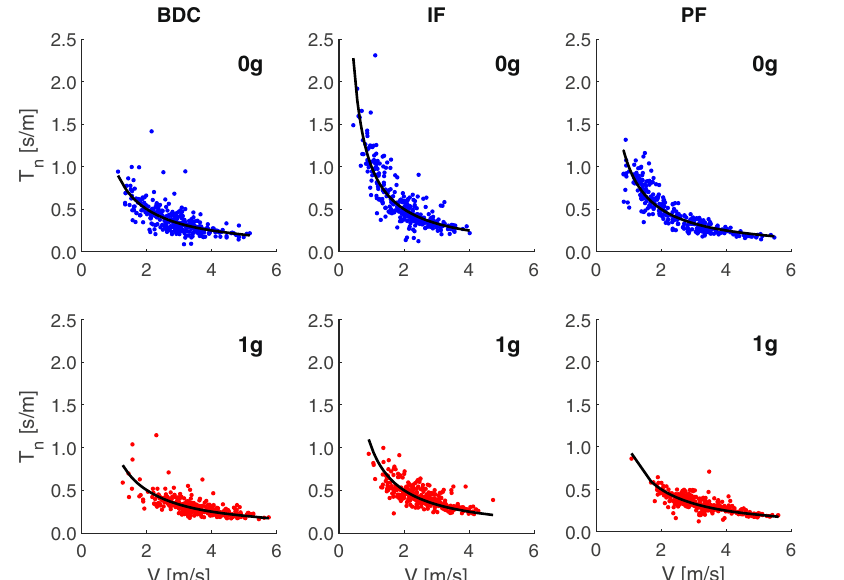
Fig. 3 Pooled normalized T vs. V . Pooled results of all trials of all participants of the main protocol with in- fl ight experiments, after normalization of the individual T values to the best- fi tting K value of each experiment. Black curves are best- fi tting hyperbolic functions over all trials of each